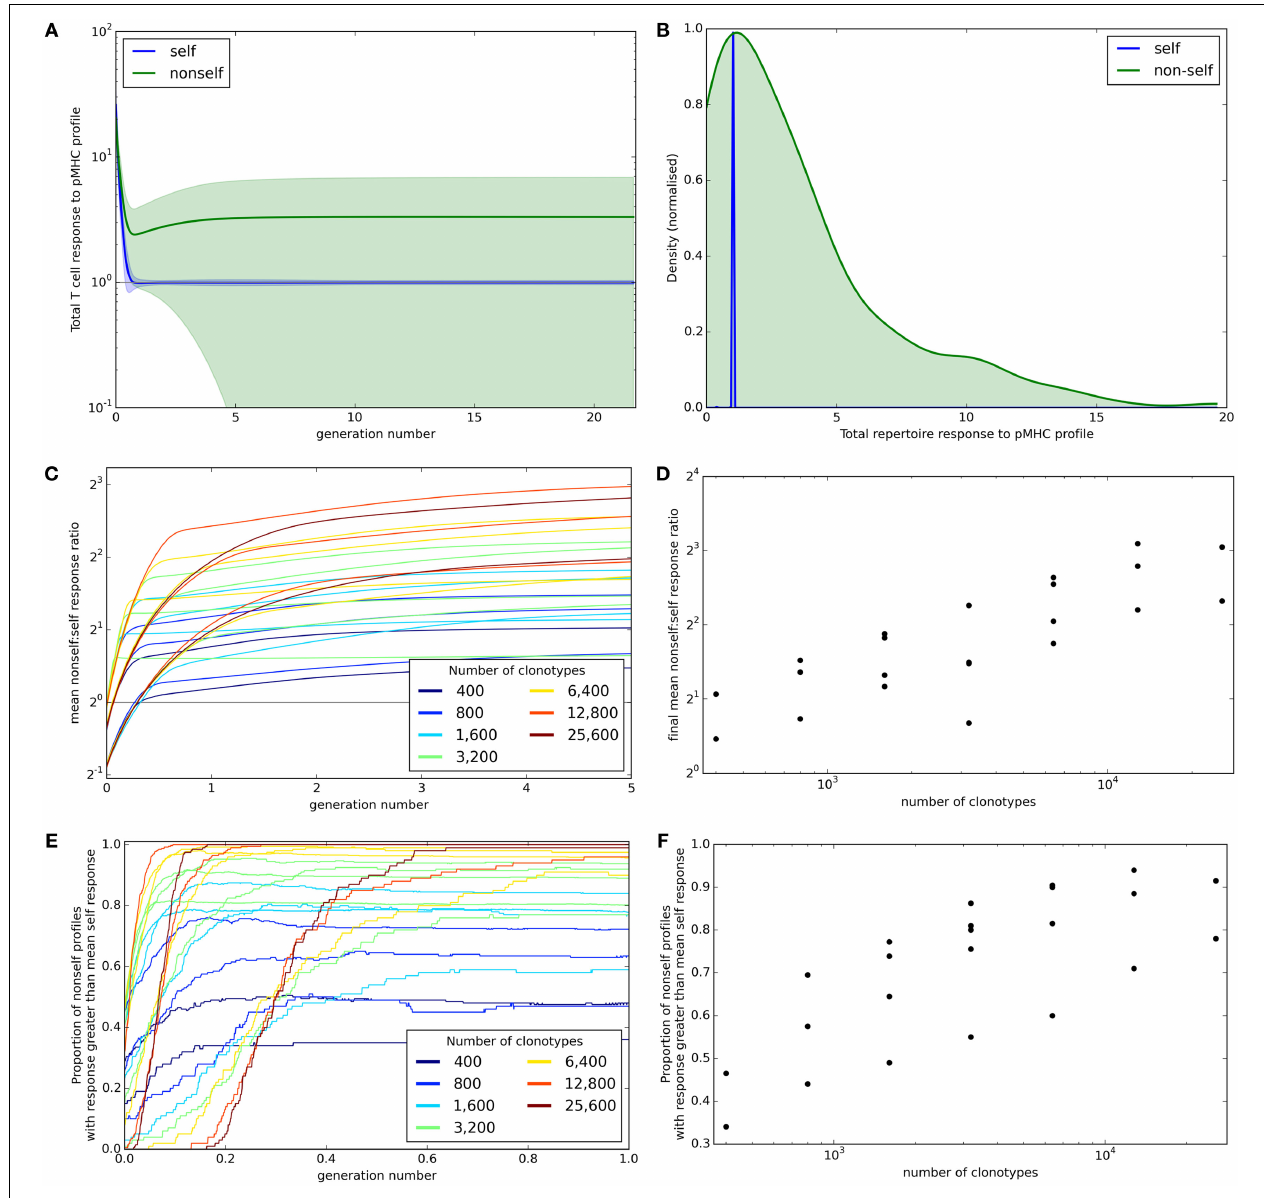
between number of T cell clonotypes and the average total response to a non-self profile divided by the average total response to a self profile after 30,000 iterations of the update algorithm. (E) The proportion of non-self profiles that have a total T cell response greater than the mean response toward self profiles over time. The number of T cell clonotypes is indicated by color. (F) The relationship between the number of T cell clonotypes and the proportion of non-self profiles having a stronger total T cell response than the mean response to self profiles after 30,000 cycles of the update algorithm. Other model parameters for all panels are: self-response threshold (cid:28) = 1, growth rate (cid:23) = ln 2 (cid:14) t –1 , learning rate (cid:17) = 0.002001 (cid:14) t –1 and proportion of non-zero affinities (cid:13) =